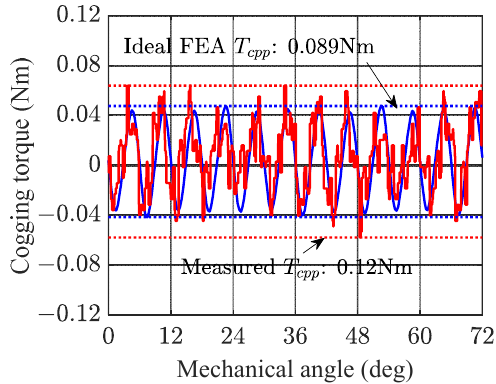
Figure 9. Cogging torque waveform (measured and ideal FEA results).